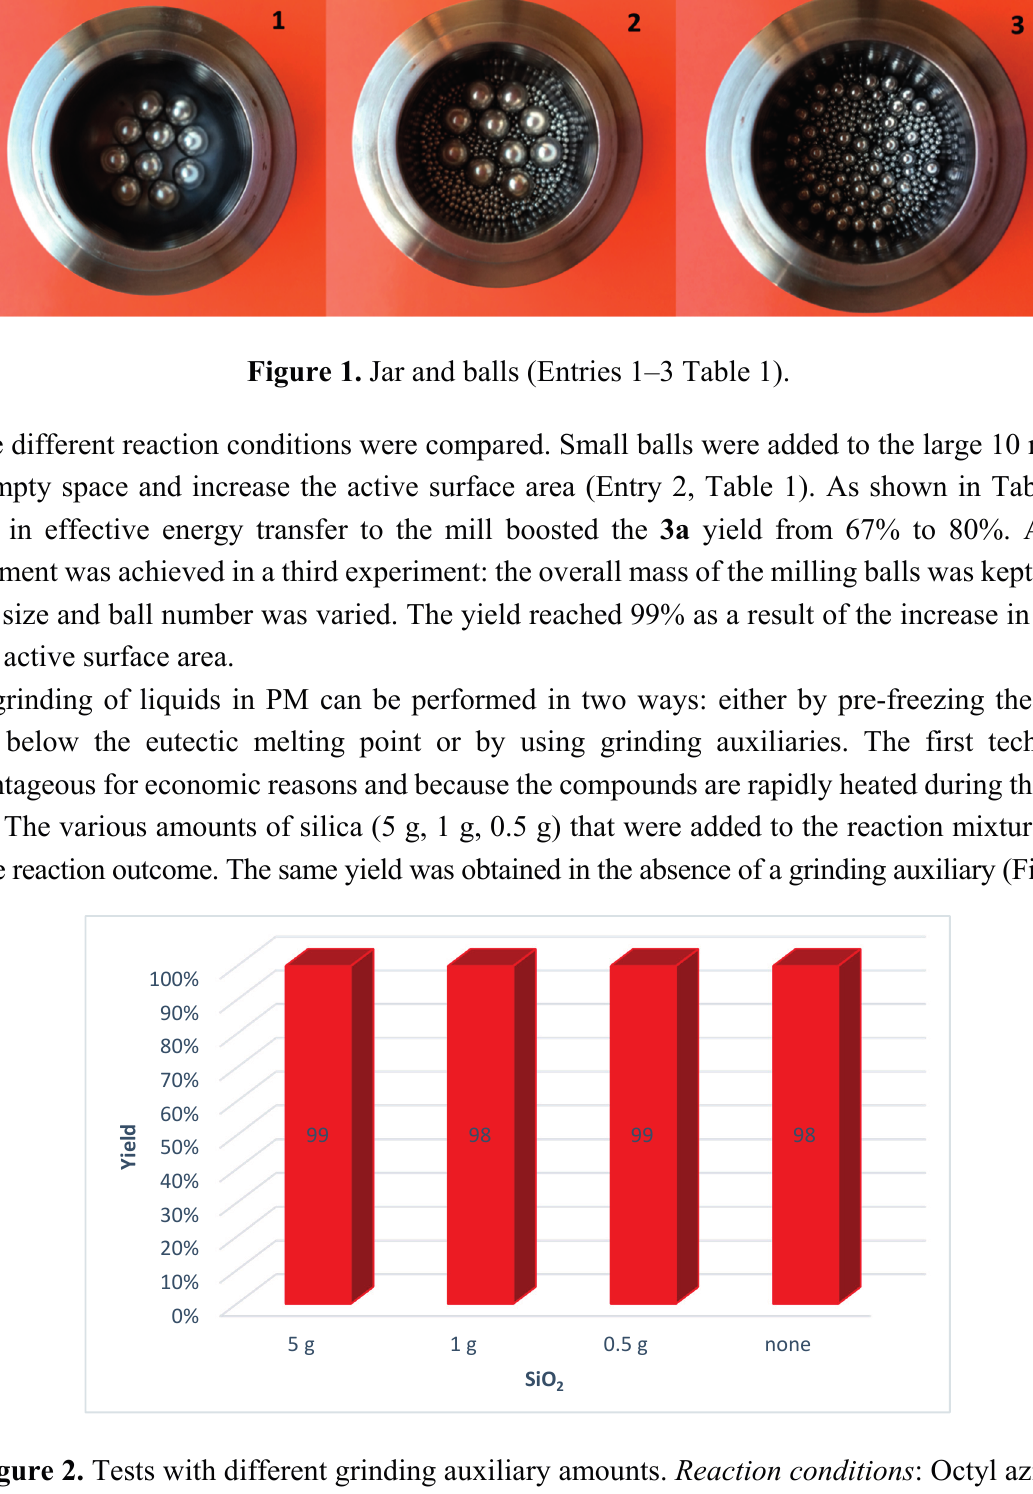
Figure 2. Tests with different grinding auxiliary amounts. Reaction conditions : Octyl azide ( 1a ) (1 mmol), phenylacetylene ( 2a ) (1 mmol), Cu powder (1 mmol), SiO 2 ; stainless